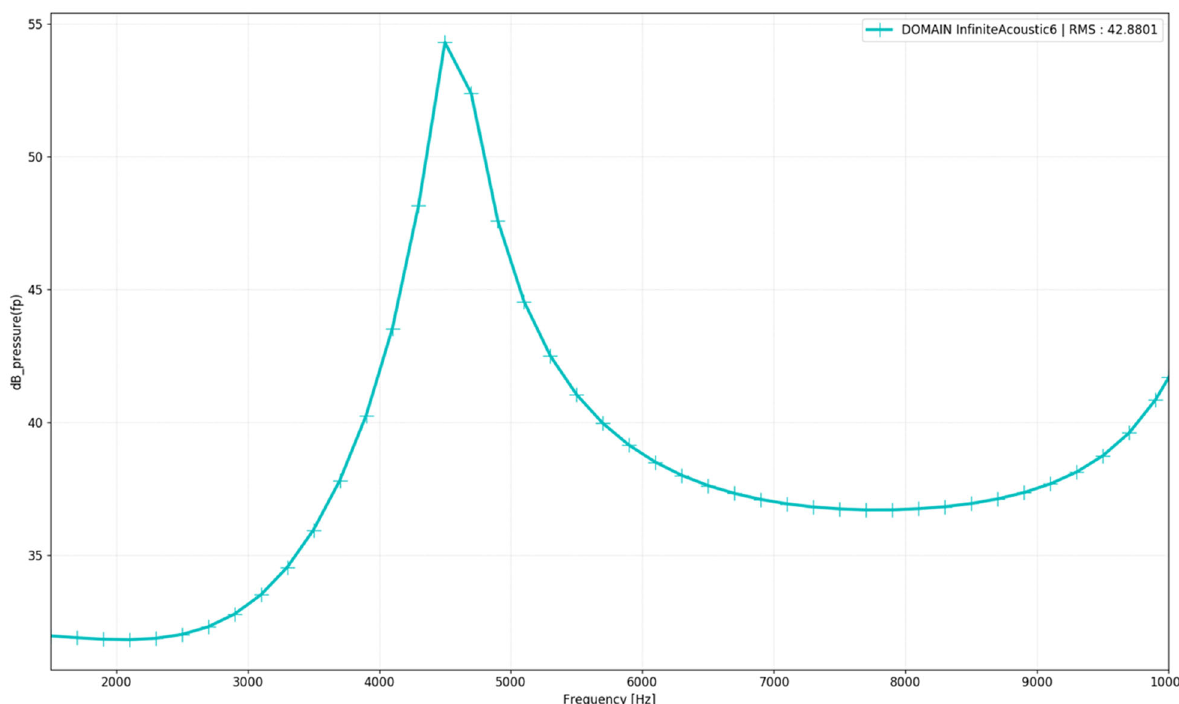
Fig. 6 The radiated sound power (dB). The radiated sound power for the measured frequency is shown.